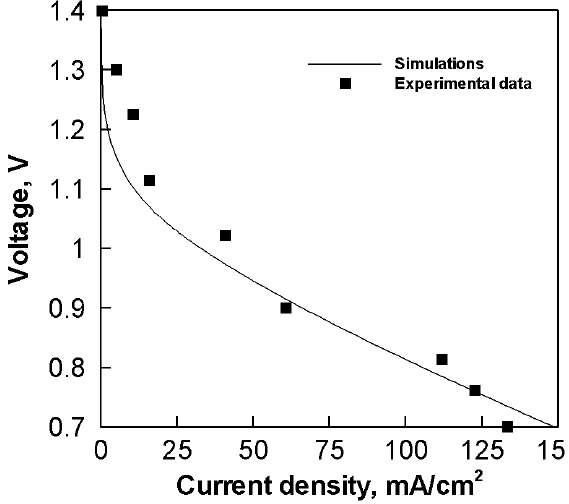
Figure 4. Comparison of predictions with measured voltage–current data of a single Zn–air fuel cell.